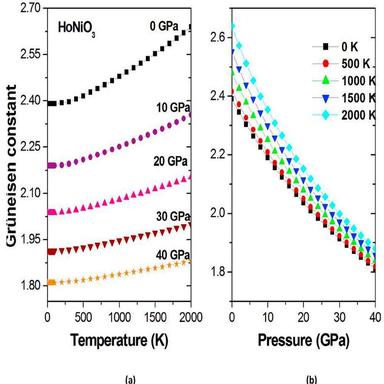
Grüneisen constant γ as a function of the temperature (pressure) at different given pressures (temperatures).